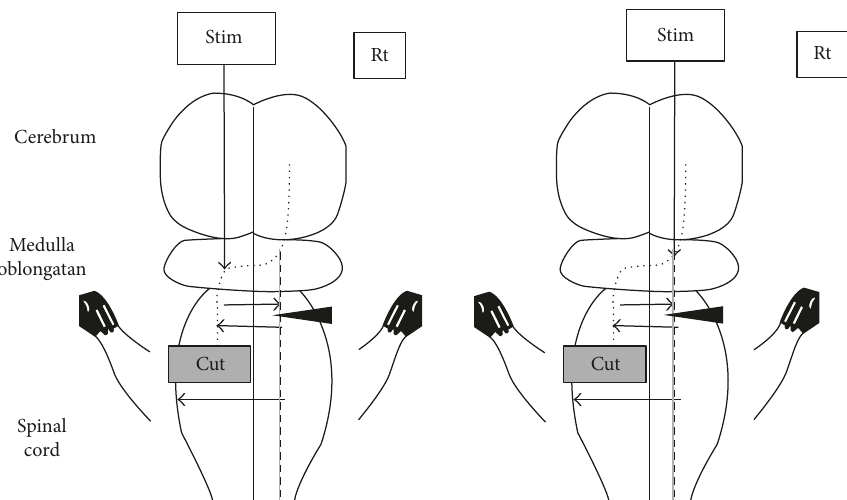
Figure 11: Compensation pathway of the corticospinal tract after the recovery of motor function. Stim: stimulation; Rt: right; cut: left C5 segmental hemisection of cervical cord; short broken line: dorsal corticospinal tract (posterior funiculus); long broken line: ventral corticospinal tract; arrow: sprouting; gray line: activation of the ventral corticospinal tract; arrow head: contralateral additional C2